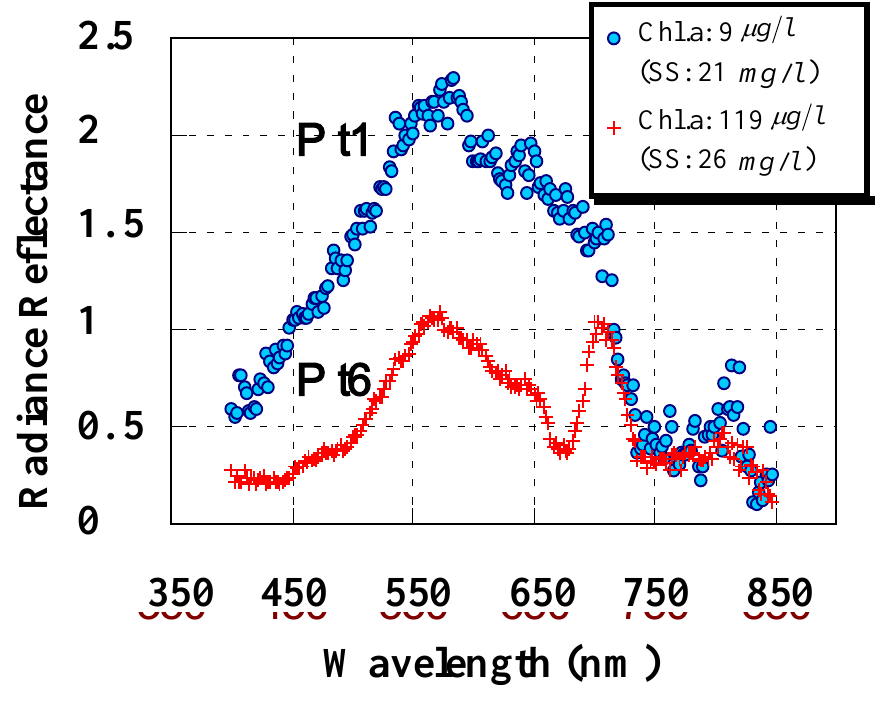
Figure 3 . Spectral reflectance calculated just above the water surface at Pt1 measured on 10 September 1993 and Pt6 measured on 22 April 1994 of Lake Kasumigaura. Chl.a = chlorophyll-a; SS = Suspended Solids